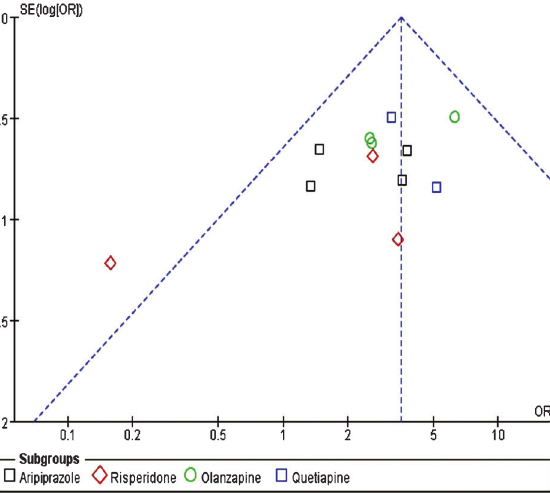
Figure 9. Funnel plot of adjunctive atypical antipsychotics in major depressive disorder for discontinuation due to adverse effects. Funnel plot was the odds ratios (OR) vs the standard error [SE(log)OR] in